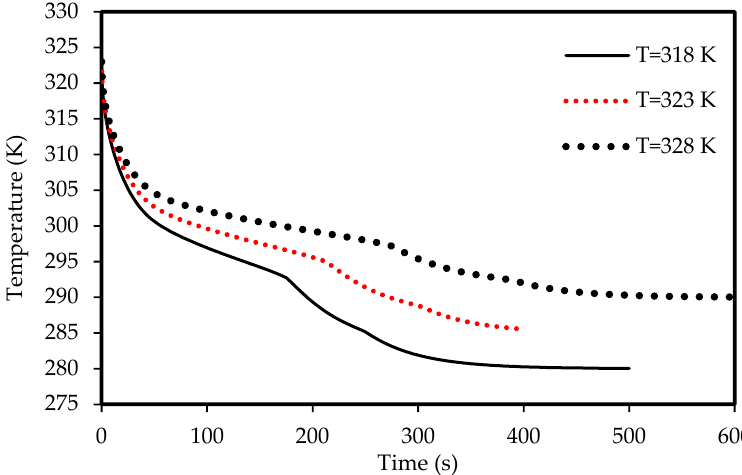
Figure 24. Variation of the temperatures for the solidification process in the horizontal corrugated channel for different airflow temperatures.